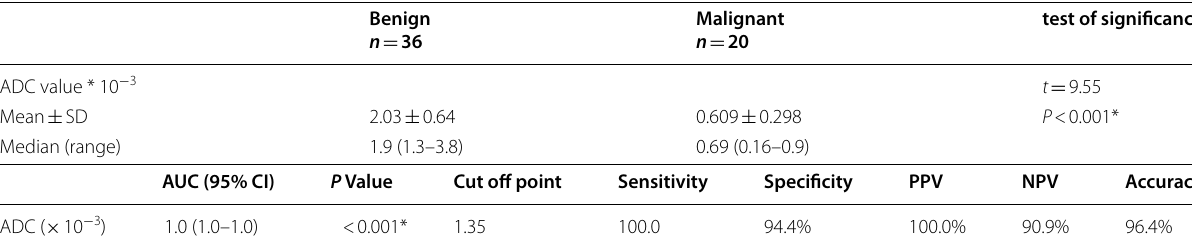
Table 4 Validity of ADC for differentiation between benign and malignant thyroid nodules